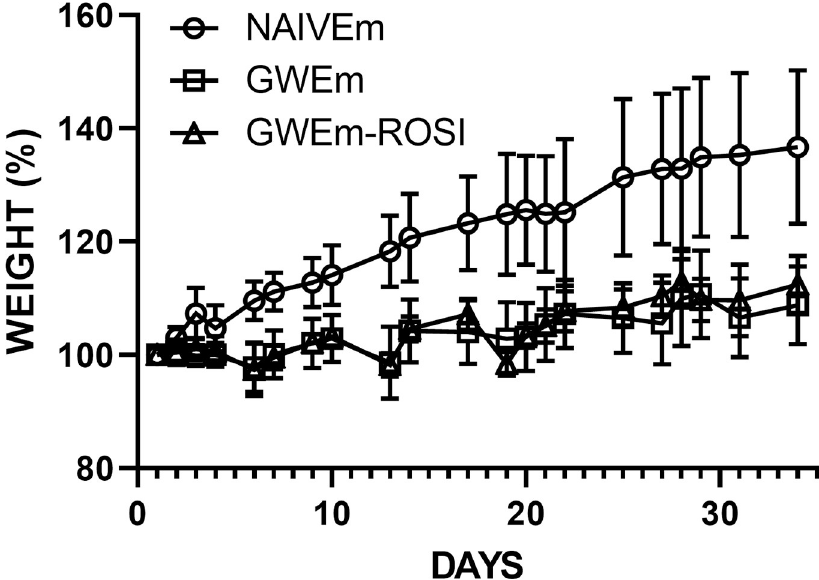
Fig 2. Normalized weight (mean ± SE) as a function of time in na ï ve male rats (NAIVEm) vs. male rats with the 33-day GWE (GWEm), including those with rosiglitazone (GWEm-ROSI).